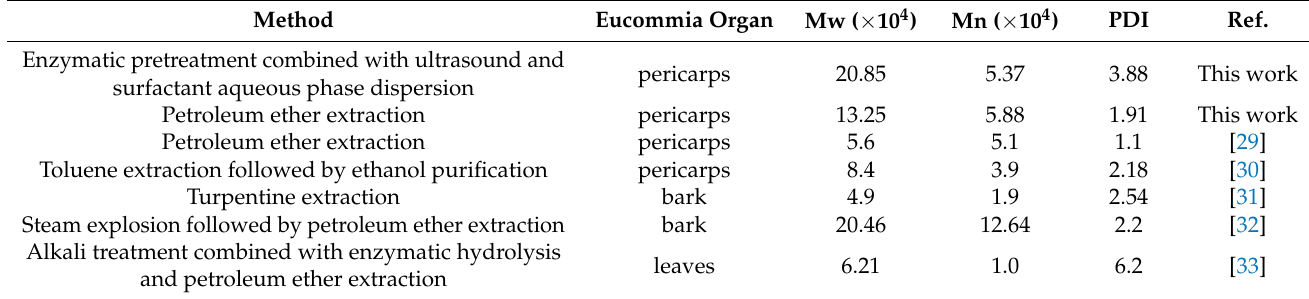
Table 3. Comparison of molecular weights and DPIs of gutta-percha extracted by different